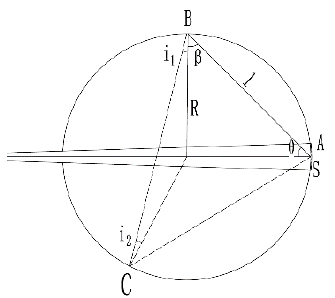
Figure 1. Principle of powersphere.